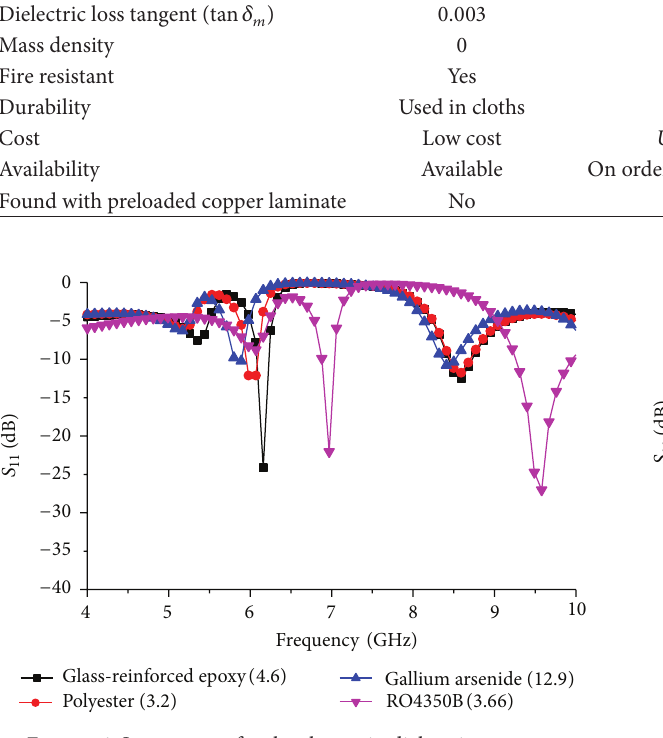
Figure 7: Resonator resonance response with changed radius of circular